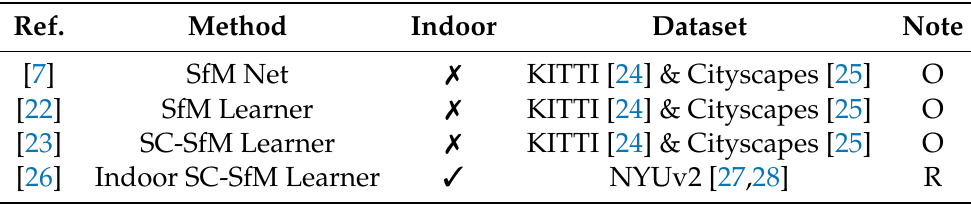
Figure 2. An illustration of the architecture used for the experiments, where I a and I b are the input RGB images; D a and D b are the corresponding estimated depth maps; and P ab is the relative camera position between I a and I b . Table 1. Methods from the literature for depth estimation from video sequences. In the column Note , symbols (O) and (R) refer to original and rectified training